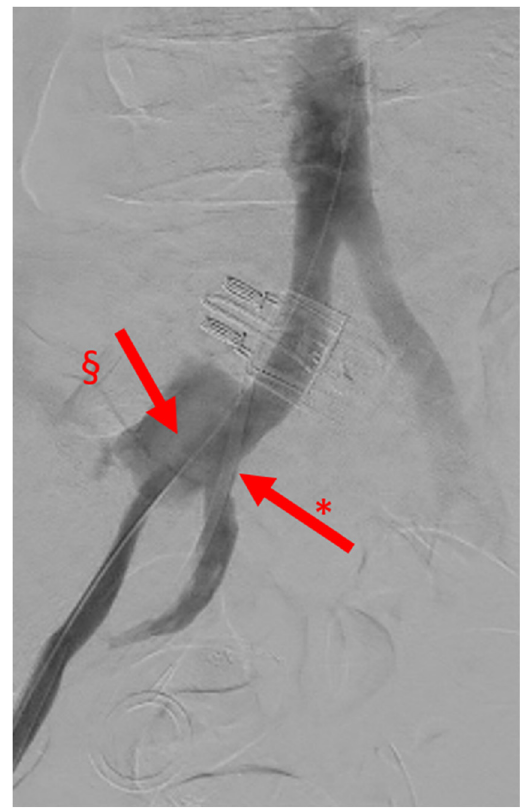
Figure 3: Angiography, image with no digital subtraction, frontal view, late arterial phase, case 1. Iodinated contrast leakage from UAF. *: right ureteral double J stent and §: contrast leakage from UAF.